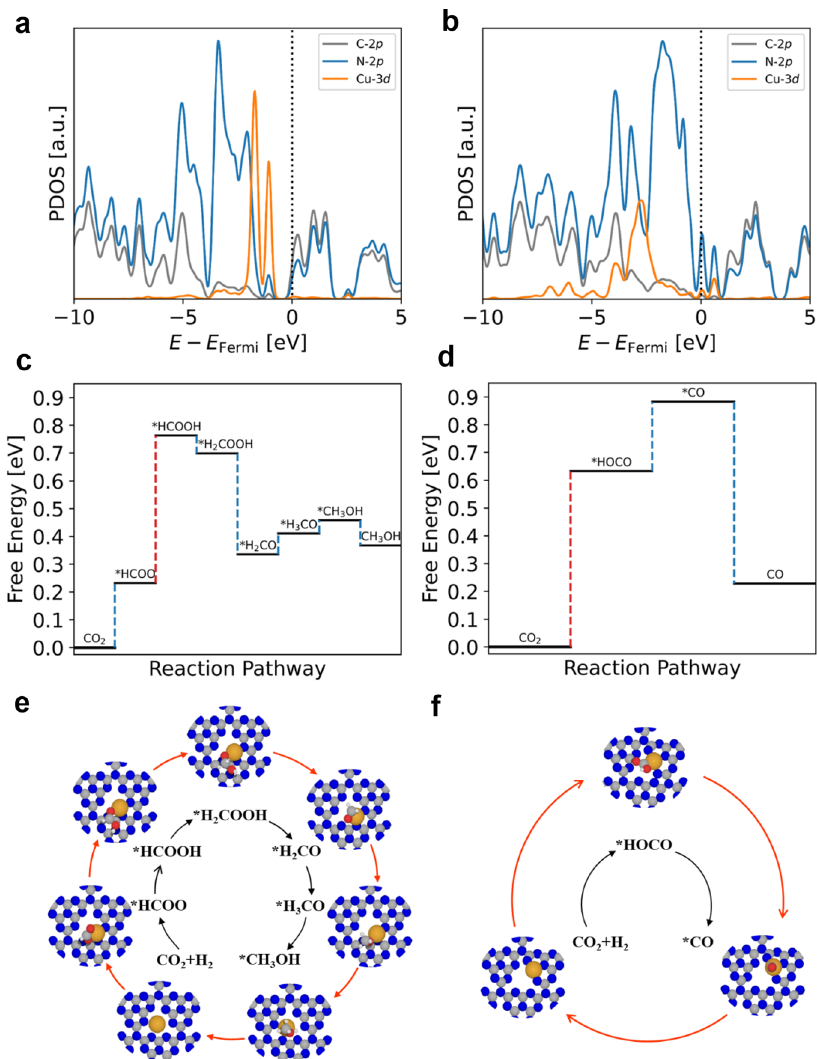
Fig. 4 Theoretical calculations and possible reaction paths for CO 2 hydrogenation. Projected density of states for ( a ) Cu – N 4 and ( c ) Cu – N 3 SACs, and the Fermi level is indicated by the dashed line. Energy pro fi les for ( b ) CO 2 hydrogenation via formate pathway over Cu – N 4 SAC and ( d ) CO 2